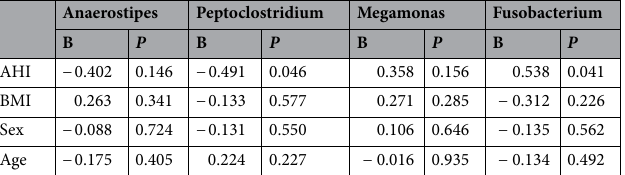
Table 3. Multiple regression analysis between microbiota signatures of severe OSA and baseline characteristics. BMI, body mass index; AHI, apnea–hypopnea